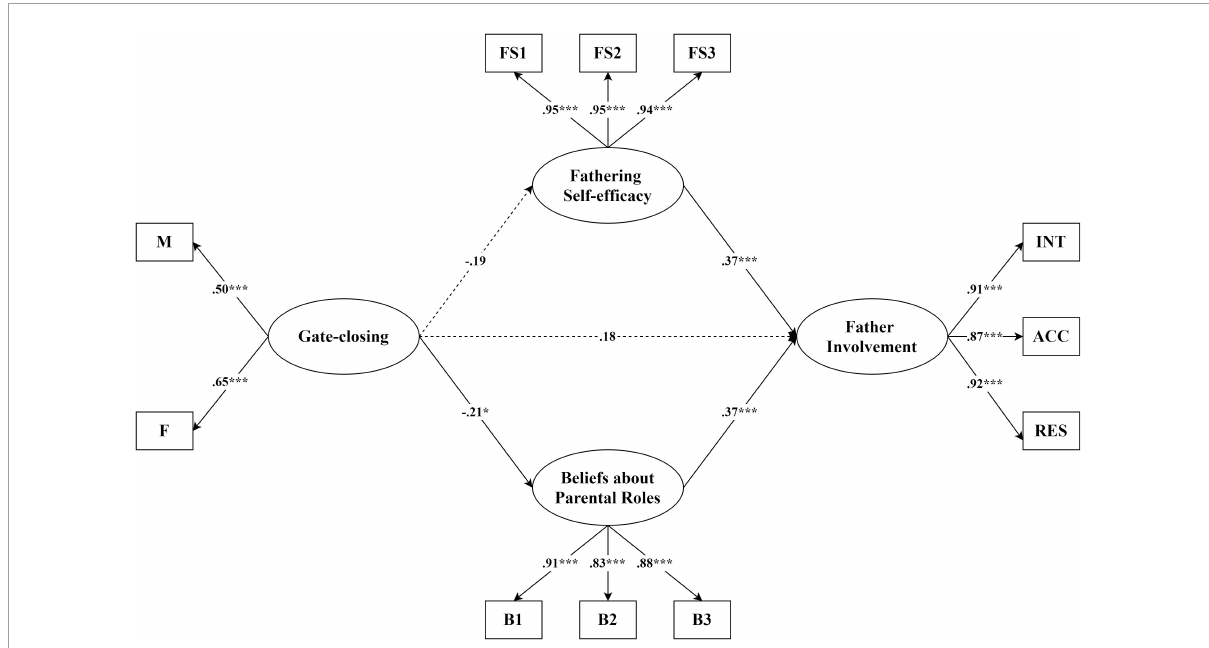
FIGURE2 Structural equation model of relationships among fathering efficacy, fathers’ beliefs, gate-closing, and father involvement. Estimates are presented in standardized units. Model fit: χ 2 (103) = 190.54, p < 0.001; RMSEA = 0.04; 90% CI [0.03, 0.05]; CFI = 0.98; TLI = 0.98; and SRMR = 0.05. * p < 0.05, *** p <